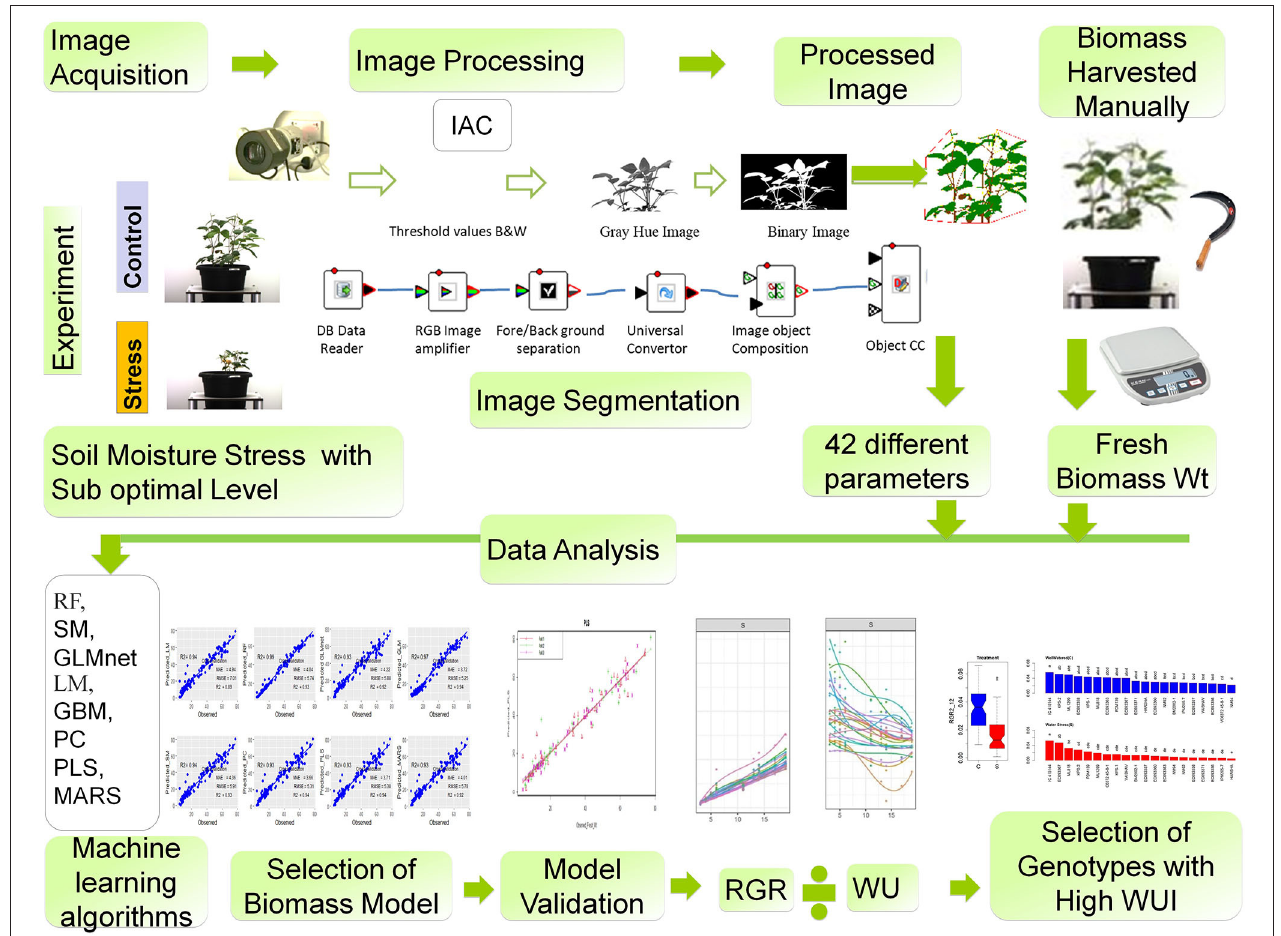
FIGURE 11 | A suggested phenotyping protocol for mungbean genotypes. Workflow for image-derived biomass model construction consists of the following steps: (1) image acquisition, (2) image processing, (3) different geometric and color-related phenotypic trait observed, (4) biomass harvested manually at the last day of imaging and fresh weight and dry weight measured, (5) different machine learning algorithms RF, SM, GLMnet, LM, GBM, PC, PLS, MARS models were used to predict plant biomass, (6) model validation, (7) model selection, evaluation, and result interpretation, and (8) selection of genotypes with high water-use index